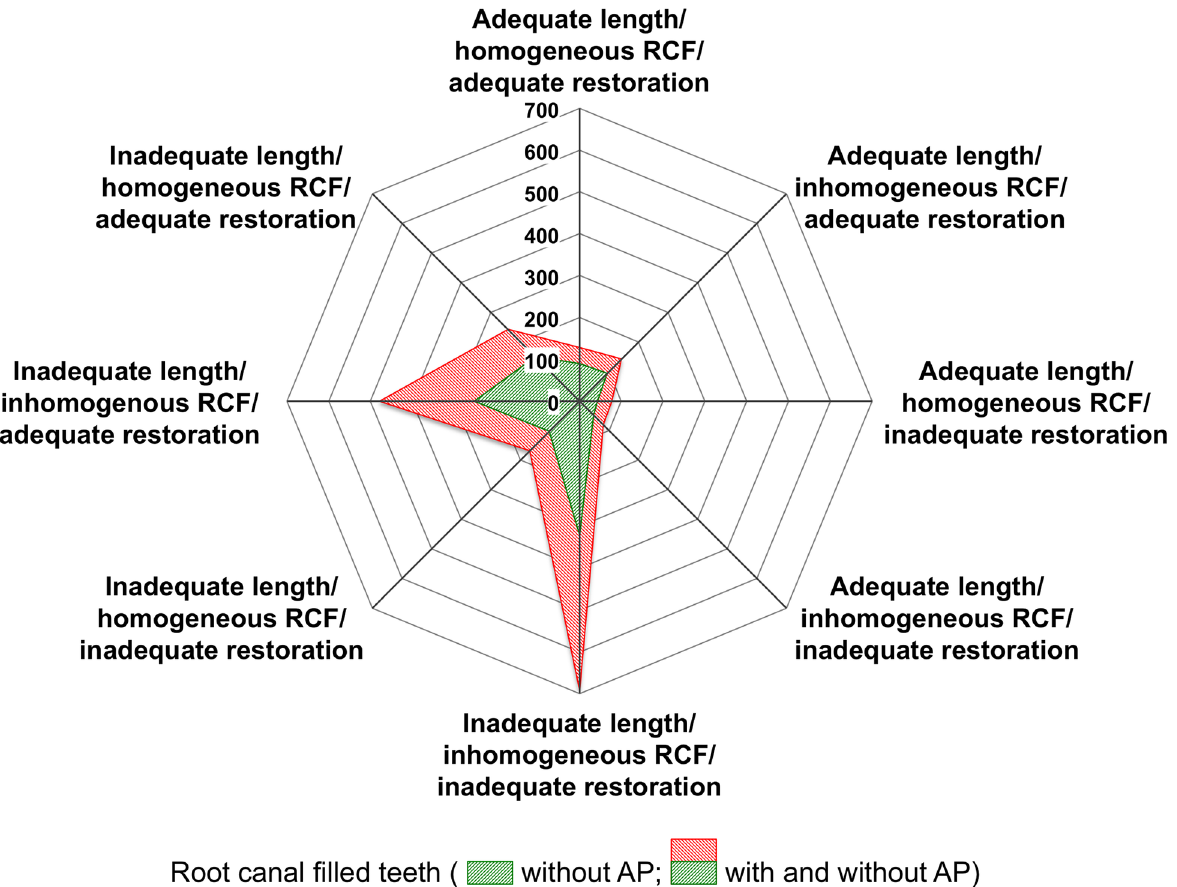
Fig 2. Kiviat diagram visualising the multivariate observations. Total amount of cases per combination is indicatedby numbers (0– 700). Inadequate length and inhomogeneousquality of root canal filling (RCF) strongly increasedthe proportionof apicalpathosis(AP), and this was again tremendously affected by poor quality of coronal restoration (n = 2,007; note that total number of teeth represents unequivocal scores of the evaluators).